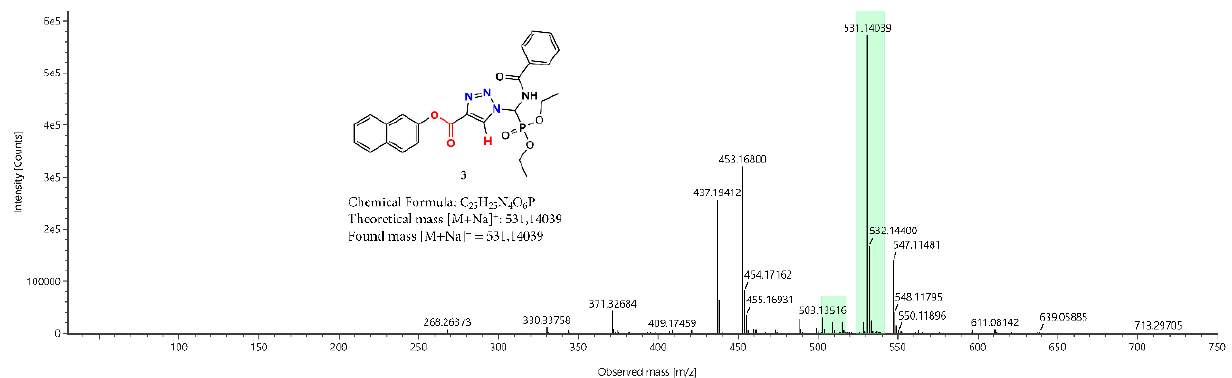
Figure 8 . IR spectrum of the cycloadduct (3). Figure 8. IR spectrum of the cycloadduct ( 3 ).